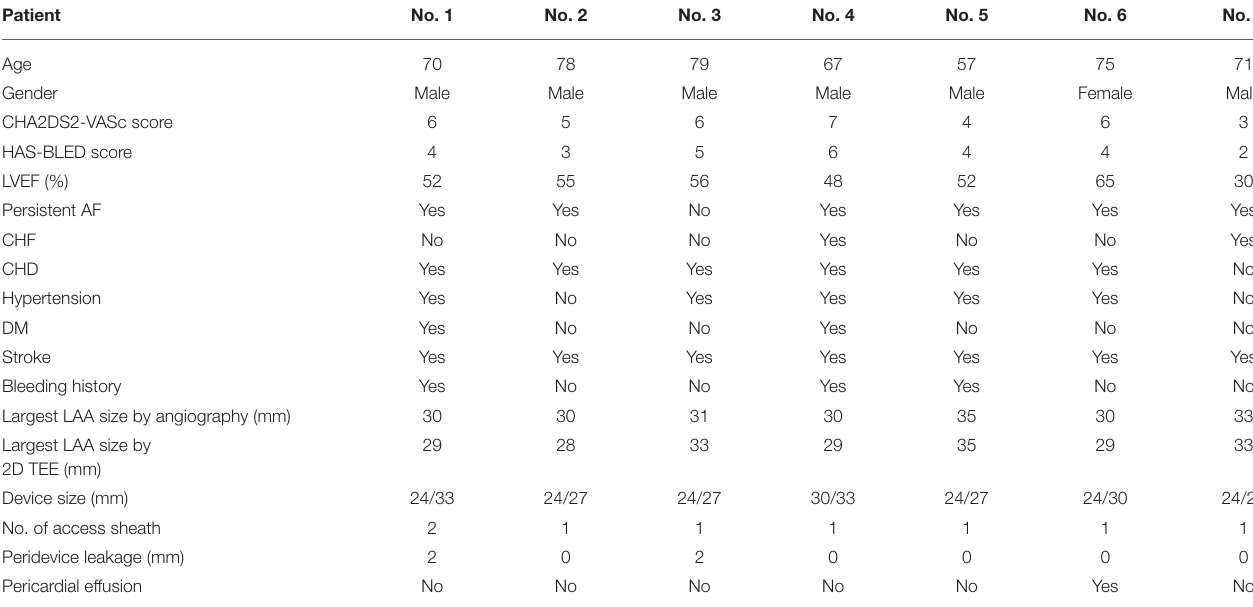
TABLE 1 | Baseline and clinical characteristics of patients.